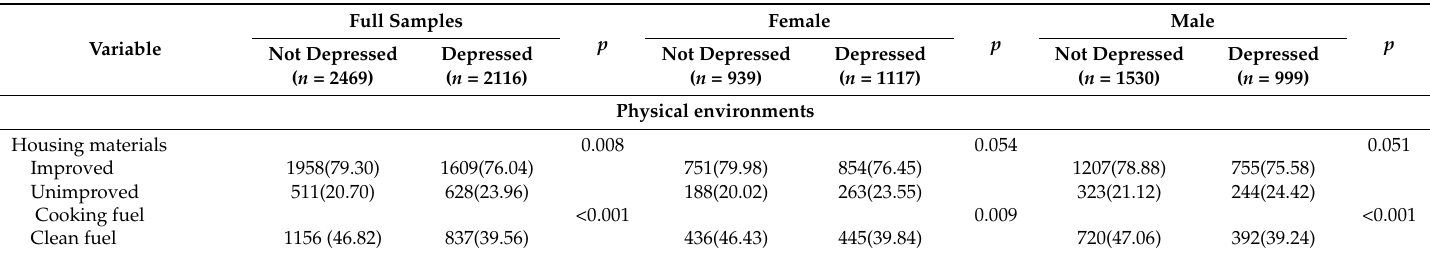
Table 2. Distribution and prevalence of depressive symptoms by gender according to physical housing environments and living